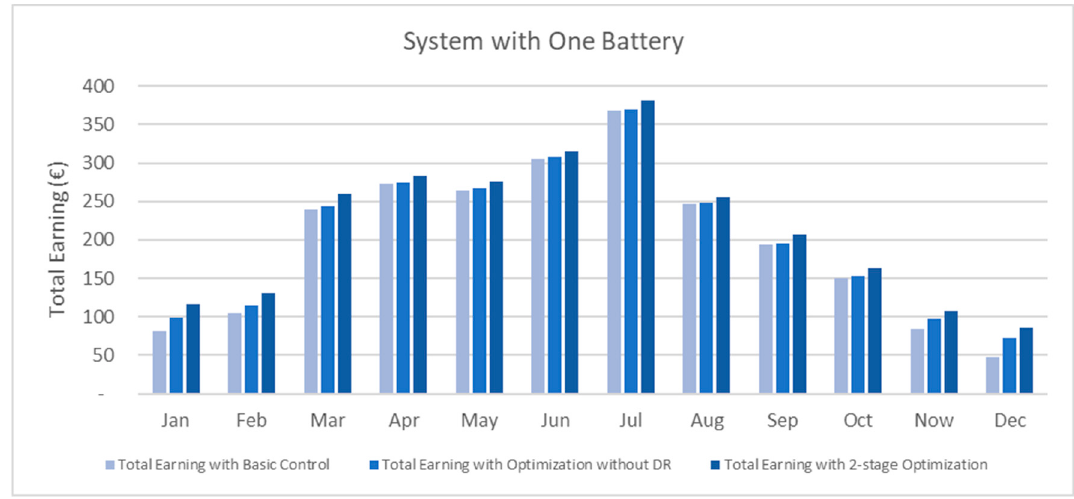
Figure 17. Methodology comparison for a one-battery case.